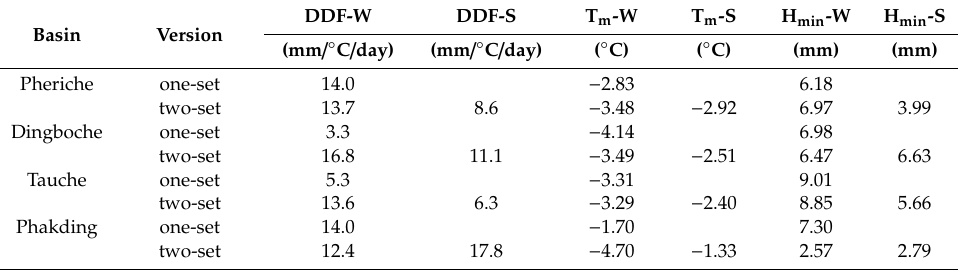
Table 5. Optimal values for snowmelt parameterization at the seasonal